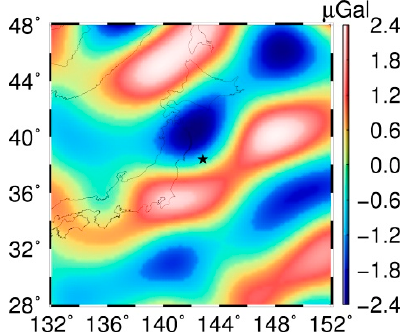
Figure 11. Gravity changes on a sphere with a height of 260 km computed by the tailored spherical harmonic coefficients from the GOCE observations with a Gaussian filter applied. The SH degree range is 30–95, and the radius of the filter is 210 km. The unit is μ Gal.